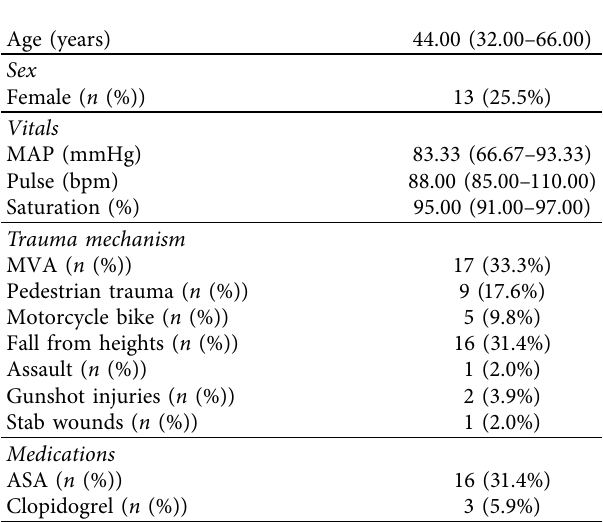
Figure 1: Flow diagram of the study population. Table 1: Demographic data, trauma mechanisms, and medications Table 3: CT findings of the study of the patients.